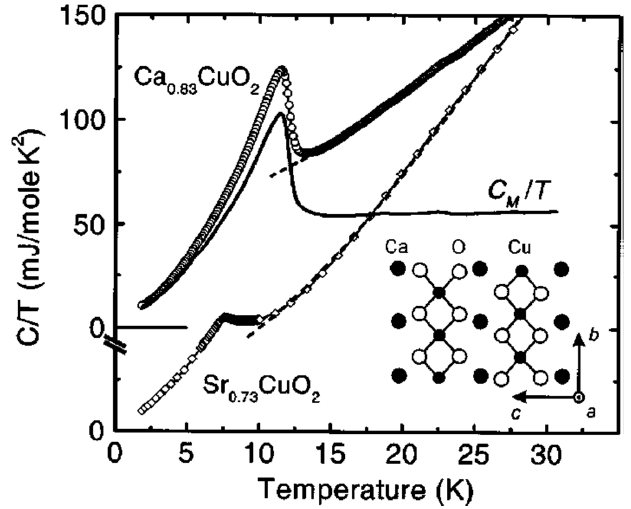
Figure 9. Specific heat C ( T ) of Ca 0.83 CuO 2 and Sr 0.73 CuO 2 . The curves for Ca 0.83 CuO 2 are offset for clarity. The magnetic contribution C M / T is shown for Ca 0.83 CuO 2 . The dashed lines are fits of ( C M / C L )/ T to the high- T data. Reproduced with permission from [89], Figure 1.